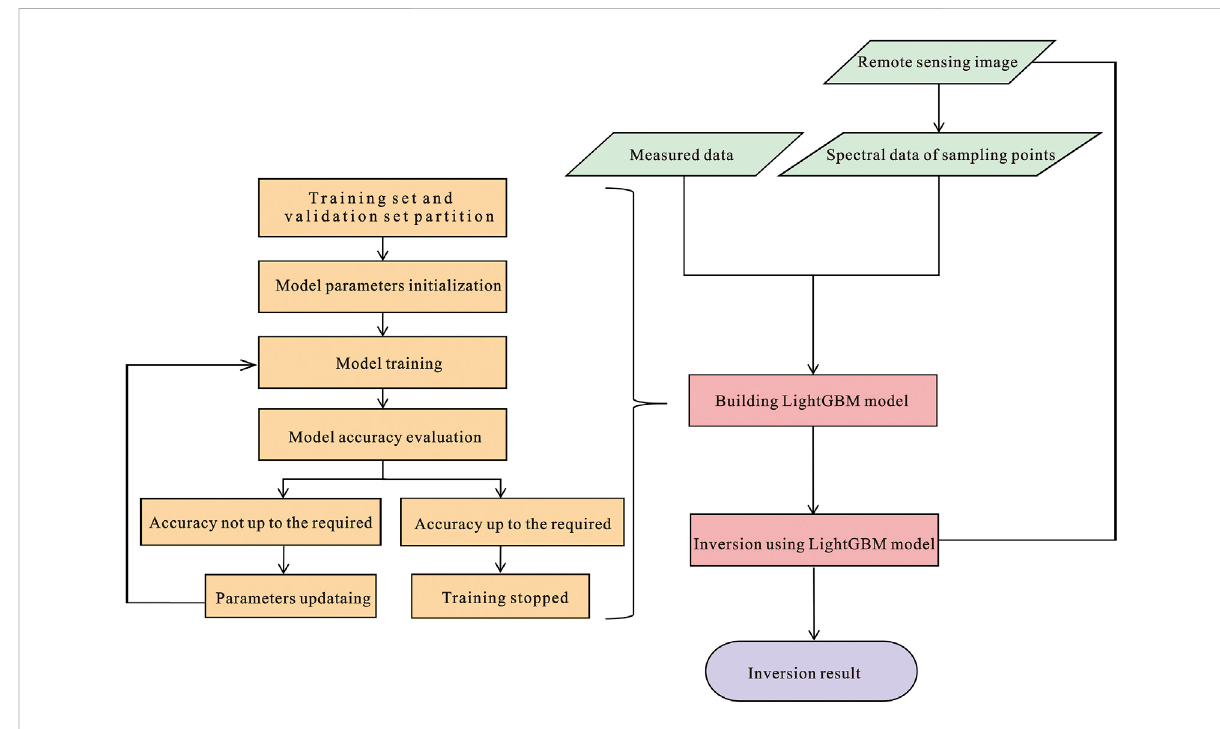
FIGURE 2 Technical fl ow chart of this